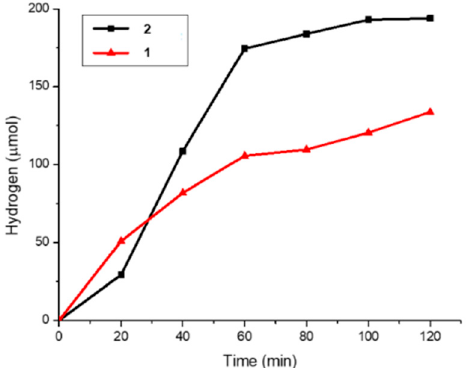
Figure 7. Comparison of visible light-irradiated hydrogen production in the presence of 0.1 mM SnP 6+ of platinized TiO 2 ( 1 ) and Nafion-coated Pt-TiO 2 ( 2 ).